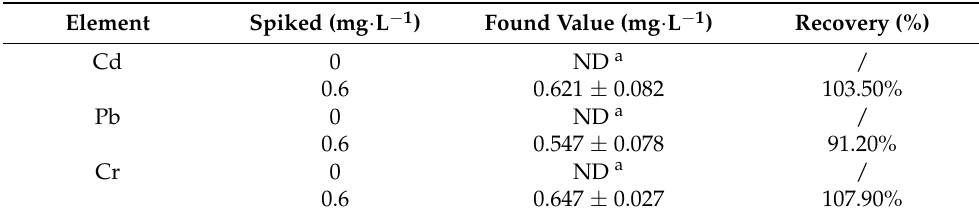
Table 2. Concentrations and recovery values of Cd, Pb and Cr in spiked lake samples.